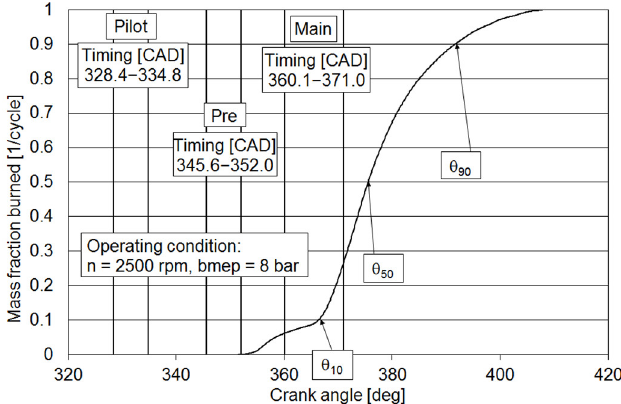
Figure 4. Example of mass fraction burned and related combustion parameters.